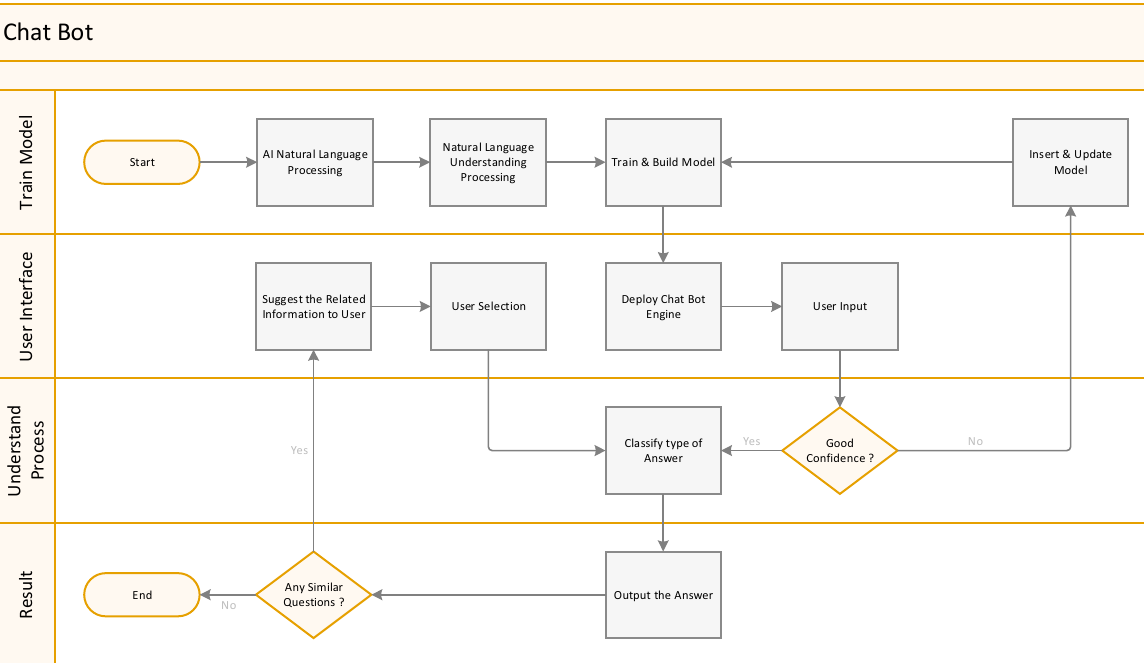
Figure 9. Flowchart of chatbot.